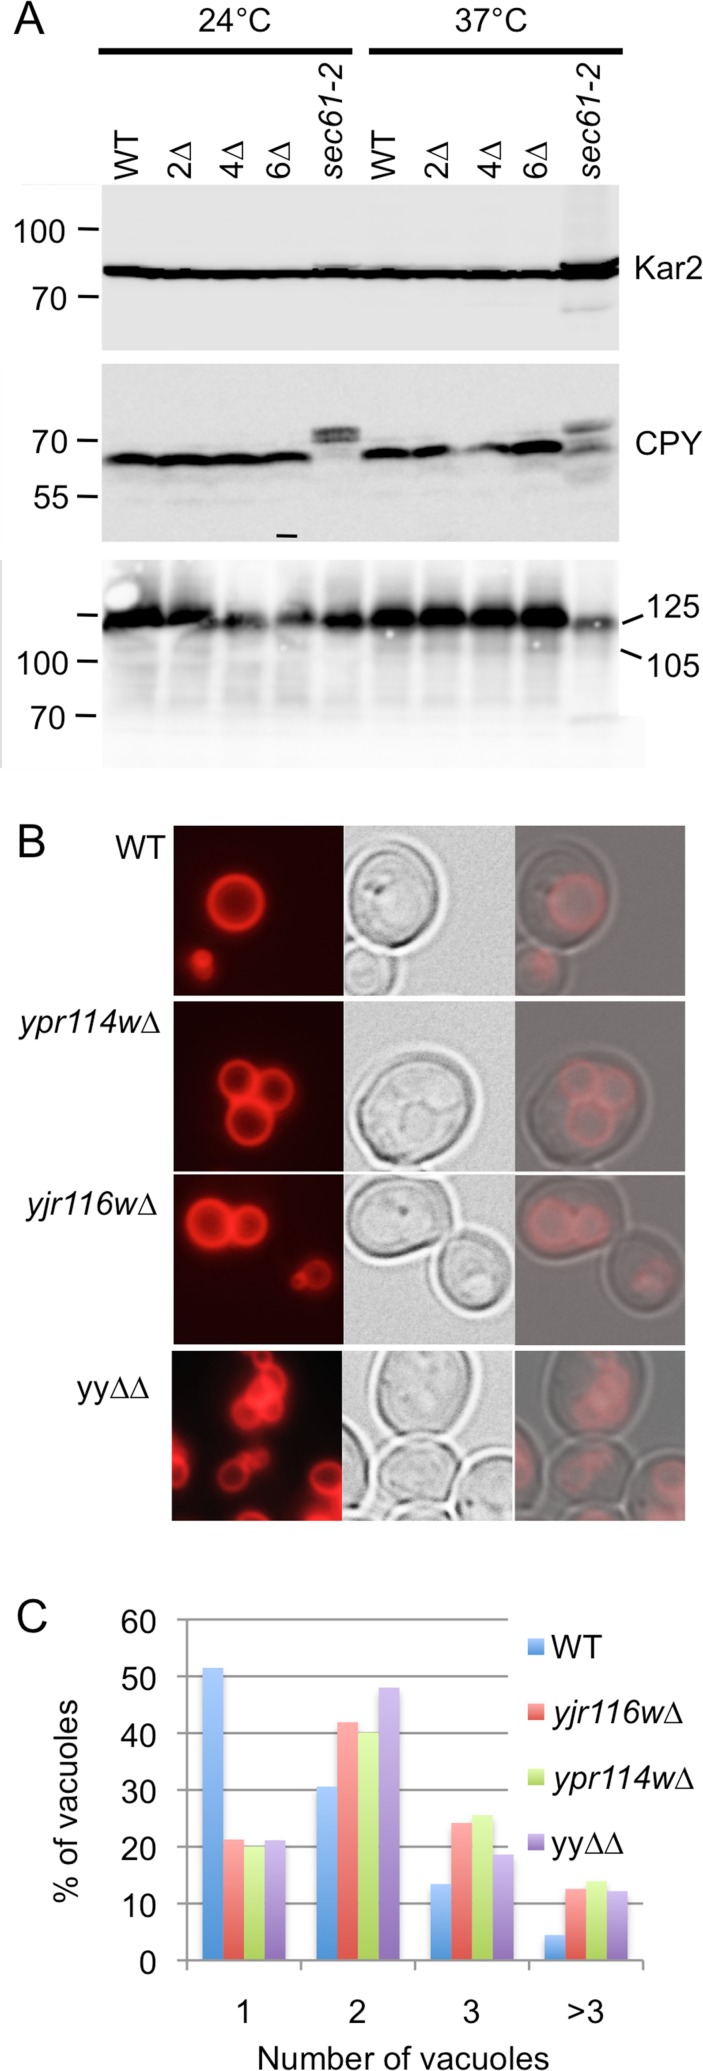
Protein targeting and organellar structures.A. Western blotting of cell extracts. Cells were grown to an OD600 of 0.8 either at 24°C or at 37°C. B and C. Vacuoles of cells growing in YPD were stained with FM4-64. Typical pictures are shown in B, the percentages of cells having 1 to >3 vacuoles are shown in C. >250 cells were inspected for each strain.